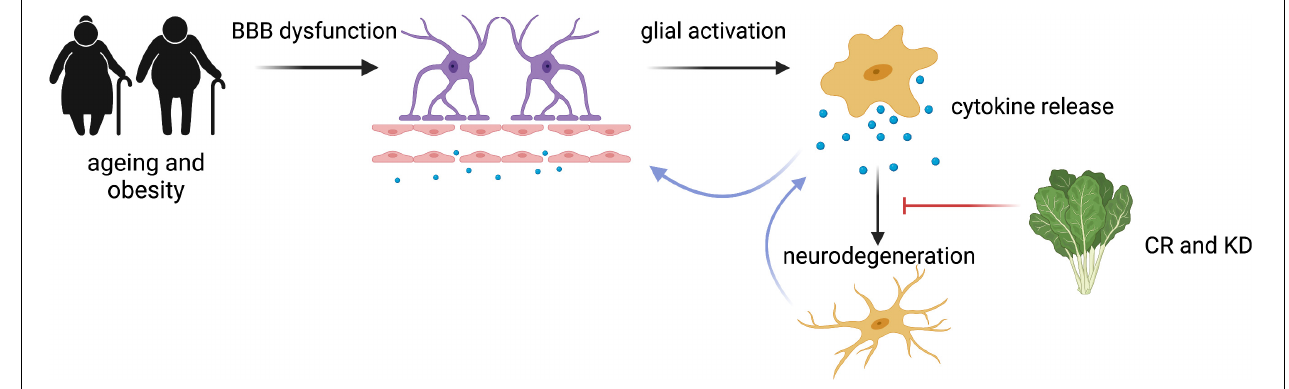
FIGURE 3 | Summary of the neuroinflammatory processes mediated by CR and KD. Ageing and obesity states result in BBB dysfunction, glial activation and cytokine release, resulting in degeneration of neuronal cells and the further activation of glial cells (Wang et al., 2018; Sheikh et al., 2022). This process can